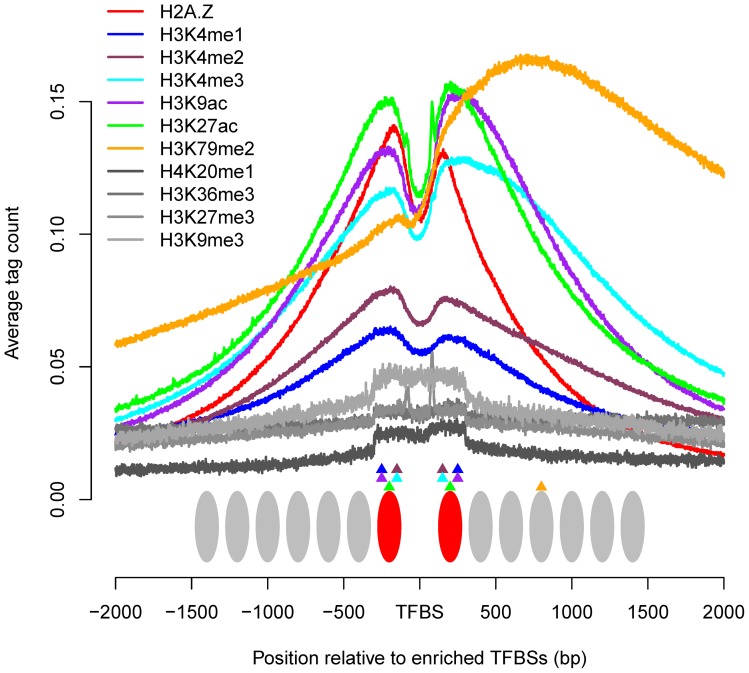
Schematic diagram illustrating the chromatin patterns around enriched TFBSs.H2A.Z, H3K4me1, H3K4me2, H3K4me3, H3K9ac and H3K27ac were located mainly within the two nucleosomes proximal to the enriched sites, while the one local maxima for H3K79me2 were located within the forth nucleosome on one side of TFBSs. The mark signals were not smoothed. The red ellipses represent H2A.Z-containing nucleosomes; the gray ellipses represent typical nucleosomes; the triangles represent different histone modifications.